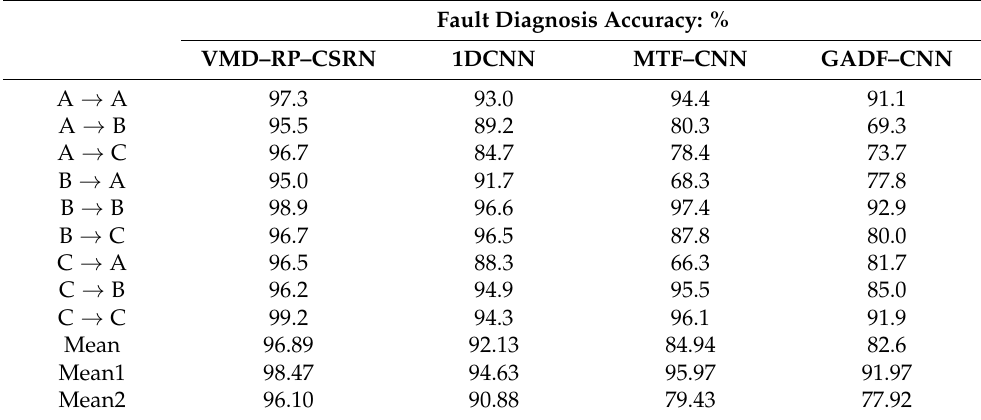
Table 3. Experimental results on the generalization performance of the VMD–RP–CSRN